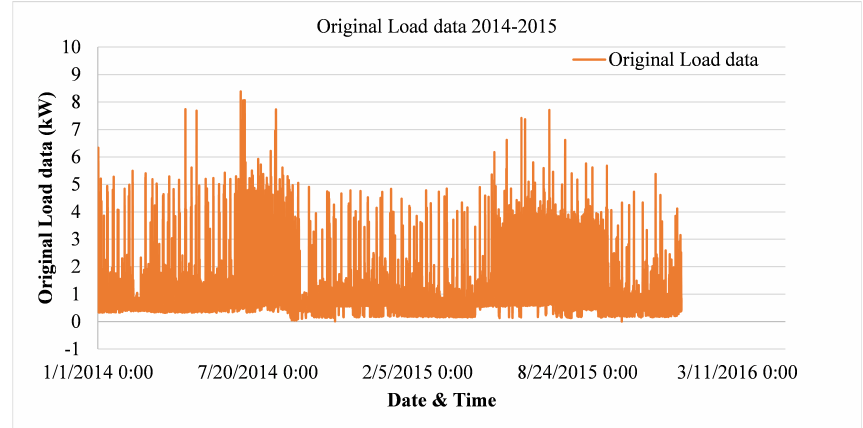
Figure 5. Actual load data for 2014–2015.